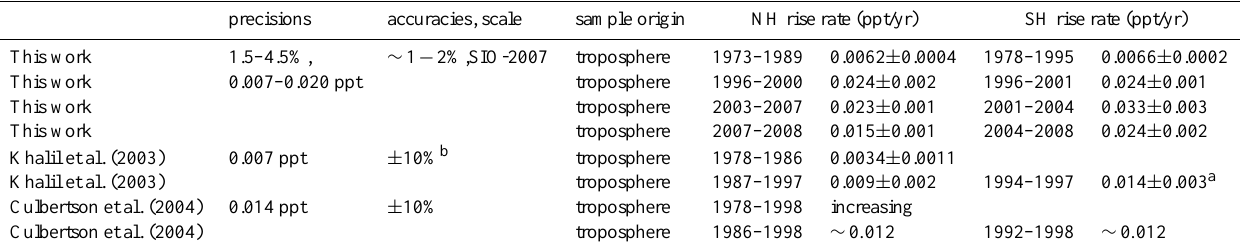
Table 5. C 3 F 8 measurement precisions, scale accuracies, sample origins, and tropospheric